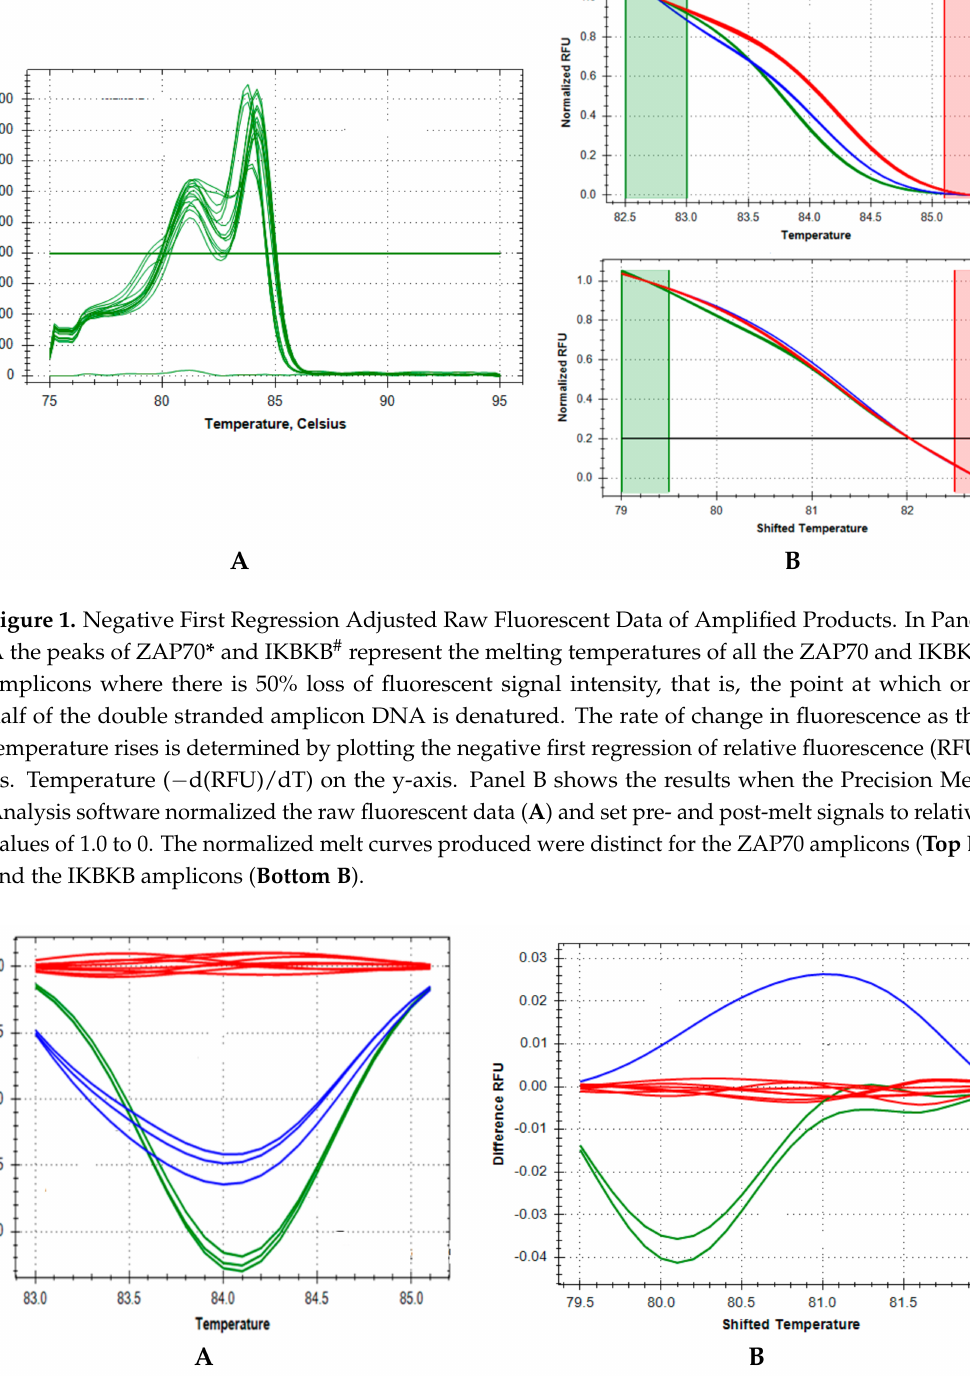
Figure 2. Representative Temperature Shifted Difference Curves. The temperature shifted difference curves further resolve clusters of the same genotype and clearly differentiate the ZAP70 homozygous affected (green line), heterozygous (blue line) and wild type (red line) genotypes ( A ) and the IKBKB homozygous affected (blue line), heterozygous (green line) and wild type (red line) genotypes ( B